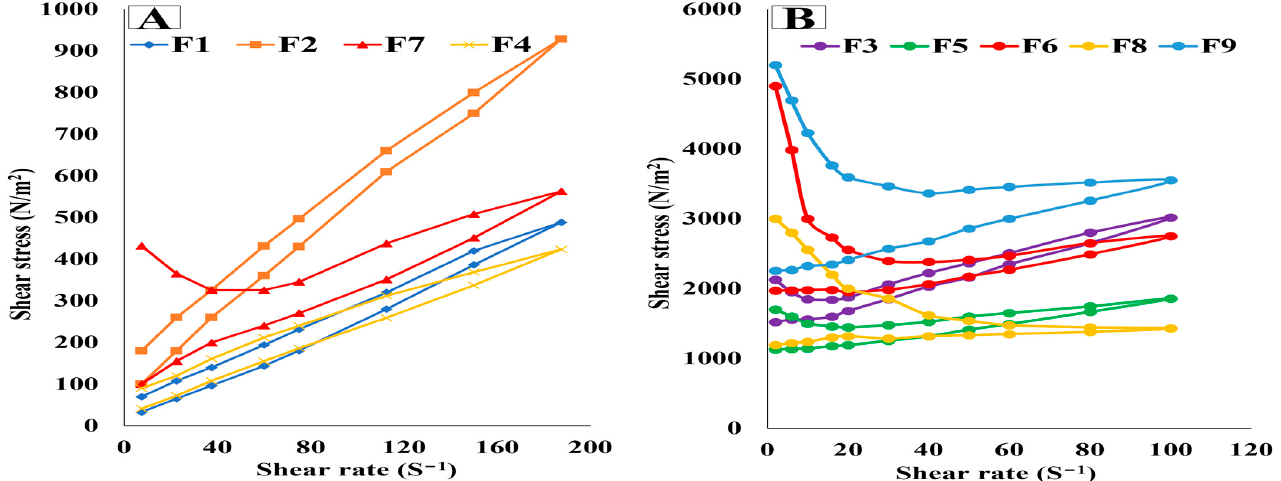
Figure 2. Rheograms showing the shear stress at di ff erent rates of shear for ( A ) low viscosity and ( B ) high viscosity oleogel